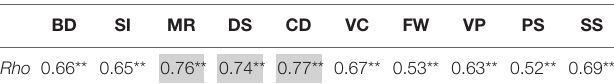
TABLE 3 | Spearman’s Correlations between FSIQ and the subtests of the